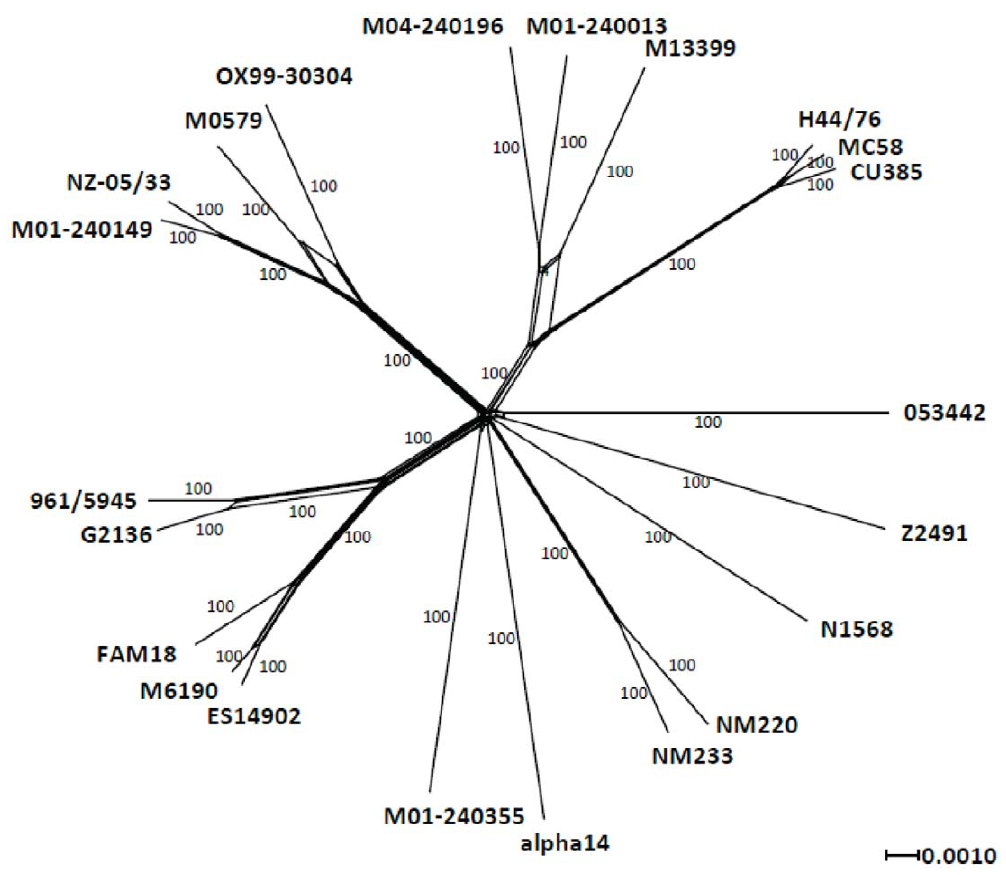
Figure 2 . NeighborNet tree of genetic relatedness of early strain type, late strain type and 20 available sequenced meningococcal genomes using aligned sequence of regions common to all genomes. Tree produced using SplitsTree. Other genomes include: GB013, 053442, 961–5945, NZ05/33, CU385, M01-240355, M01-240149, M13399, M04-240196, H44/76, N1568, M6190, Z2491, G2136, M0579, FAM18, MC58, OX99-30304, alpha14, and ES14902.